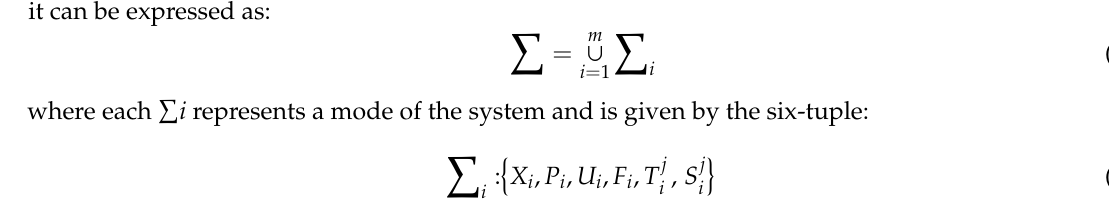
Figure 4. Bumpless mode switching control structure.